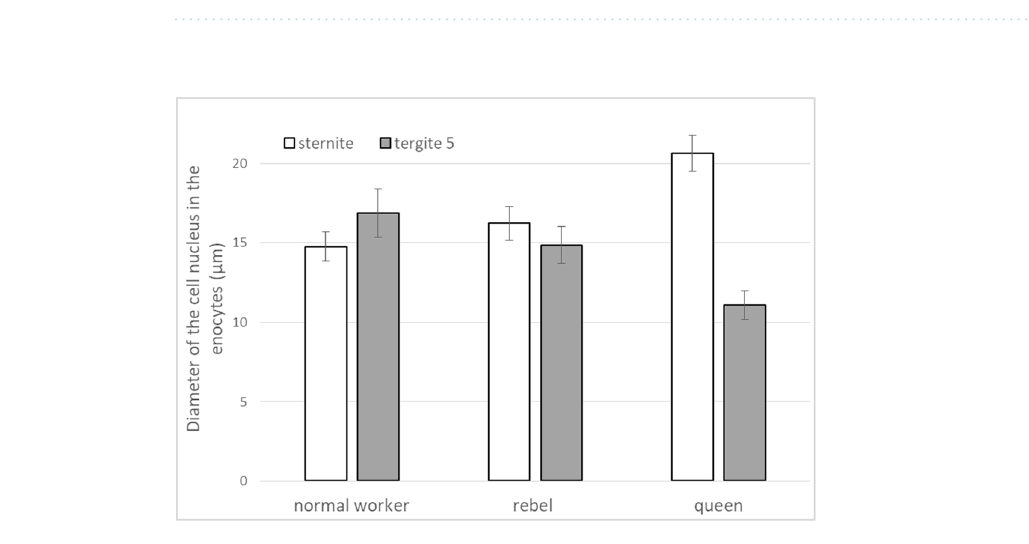
Figure 2. Diameter of the cell nucleus in the oenocytes (µm; mean ± SD) of 1-day-old queens, rebels and normal workers. The differences are statistically significant between averages for rebels and normal workers and queens (Two-way ANOVA with multiple comparison testing using the post hoc Tukey HSD; caste/sub- caste F 2,31 = 0.45, p = 0.64; tissue F 1,31 = 169.81, p < 0.001; caste/sub-caste* tissue F 2,31 = 219.77, p < 0.001; no. of queens = 13; no. of rebels = 14; no. of normal workers = 10). The post-hoc Tukey test showed that there are differences between tissues and castes/sub-caste at max p = 0.023. Tergite 5—the fifth